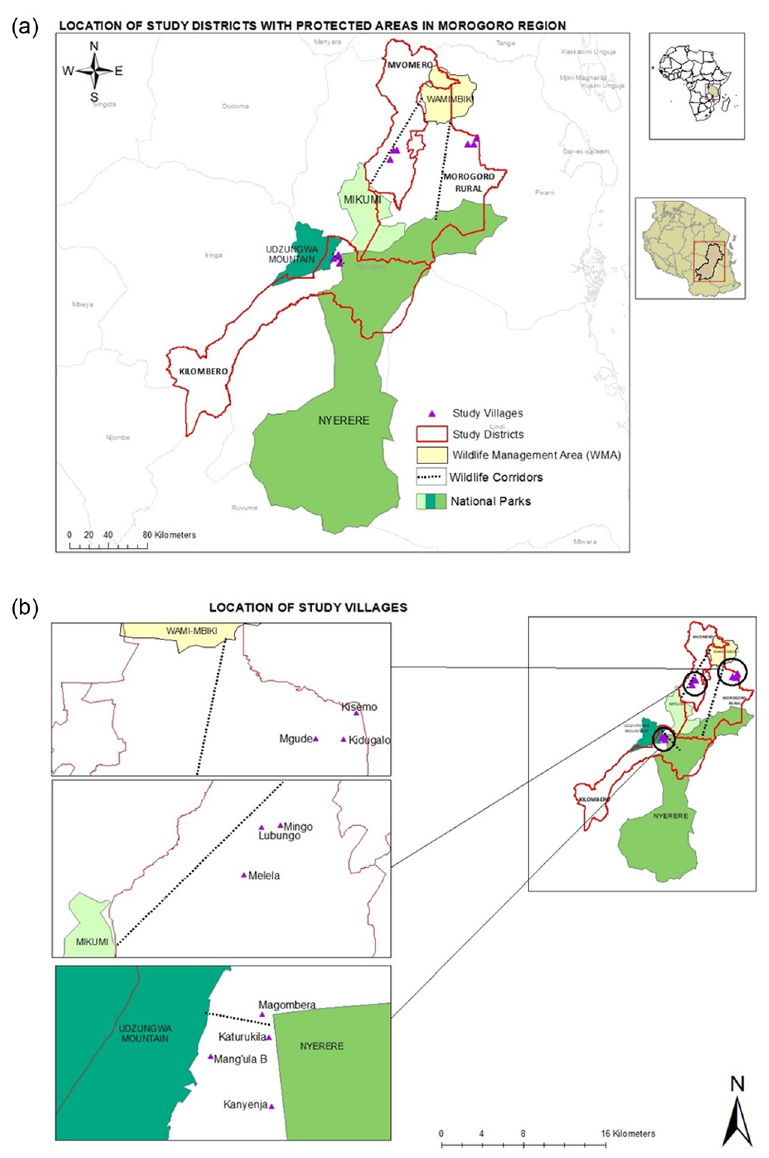
Fig 2. The location of the study area: a) the three districts of Kilombero, Mvomero and Morogoro Rural, and the nearby protected areas; b) The study villages in each of the districts. (The basemap and inserts in Fig 2(a) are similar but not identical to those in United States Geological Survey (USGS) (TNM Download v2 (nationalmap.gov)) and are used here for illustrative purposes